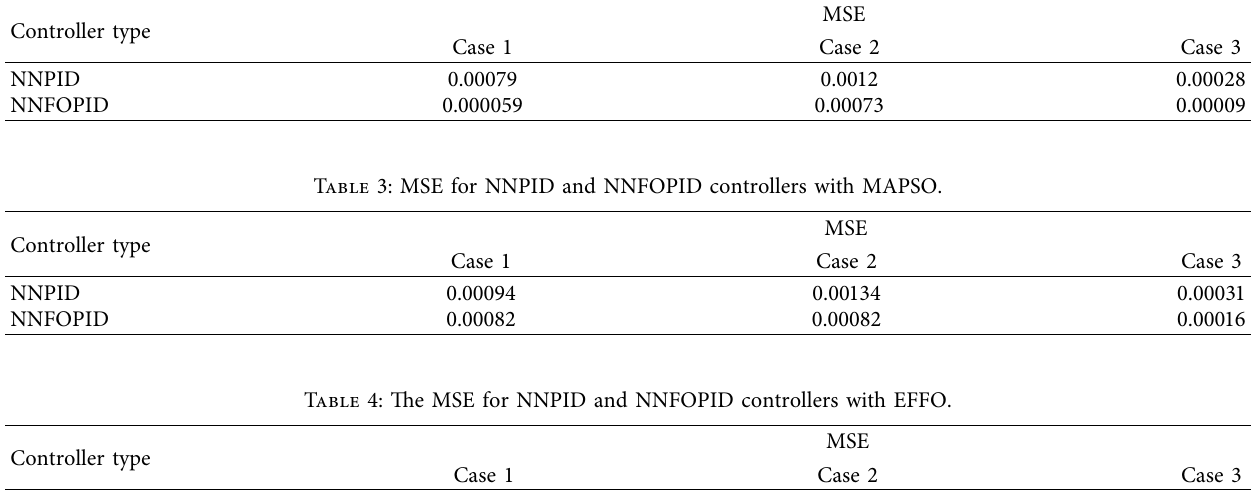
Table 2: The MSE for NNPID and NNFOPID controllers with MAPSO-EFFO.